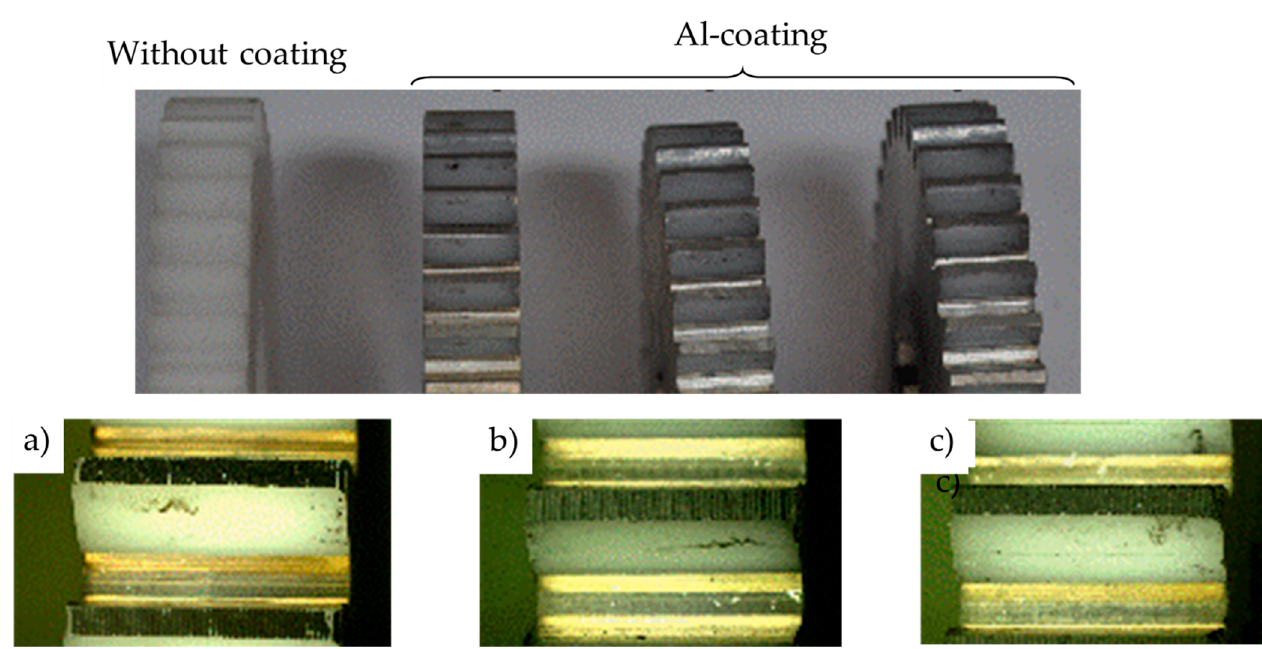
Figure 10. Wear of uncoated and coated polymer gears: ( a ) One coating layer; ( b ) Three coating layers; ( c ) Five coating layers.